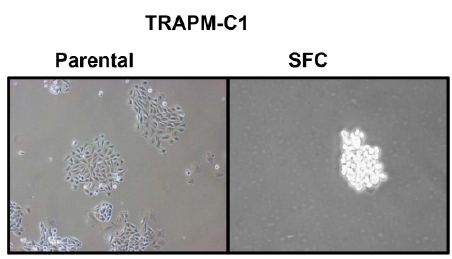
Figure A3. The image of TRAMP-C1 parental cells and SFCs.